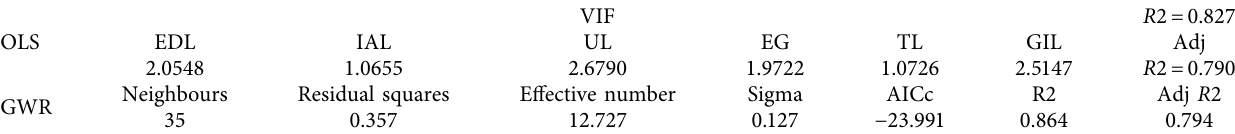
Table 6: Regression comparison between OLS and GWR